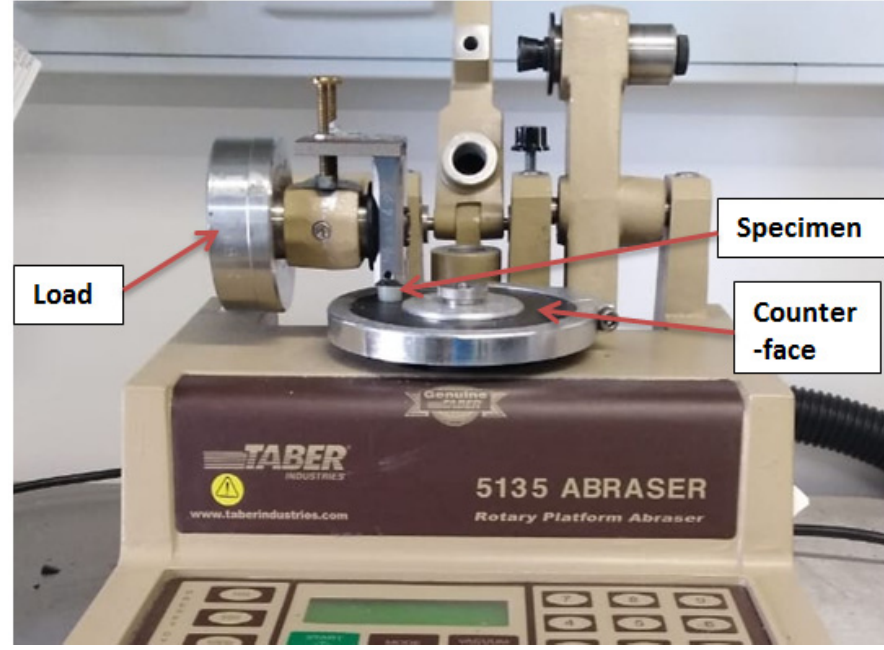
Figure 4. The testing setup using the tribometer apparatus, 5135 Abraser .